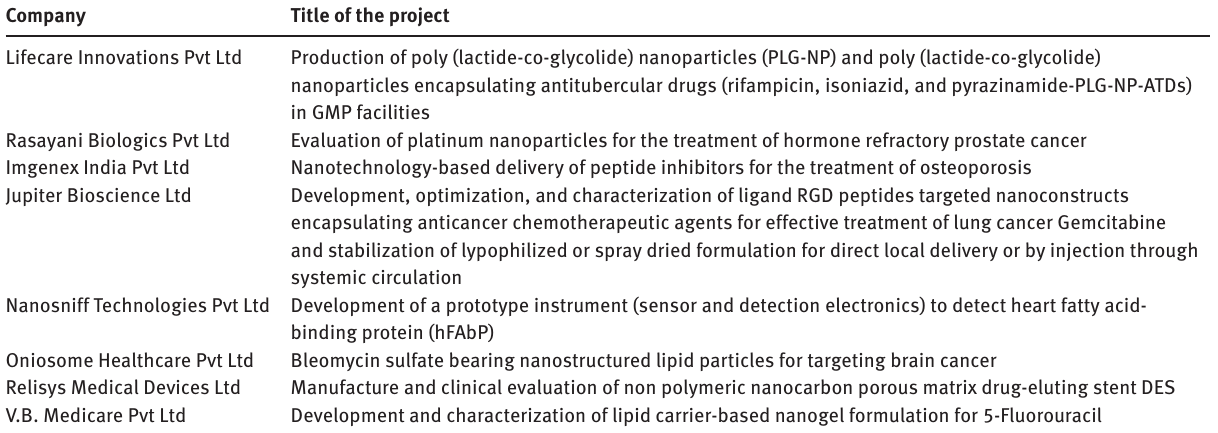
Table 1: List of projects funded by BIRAC under academia-industry collaboration (source: compiled by authors from BIRAC).